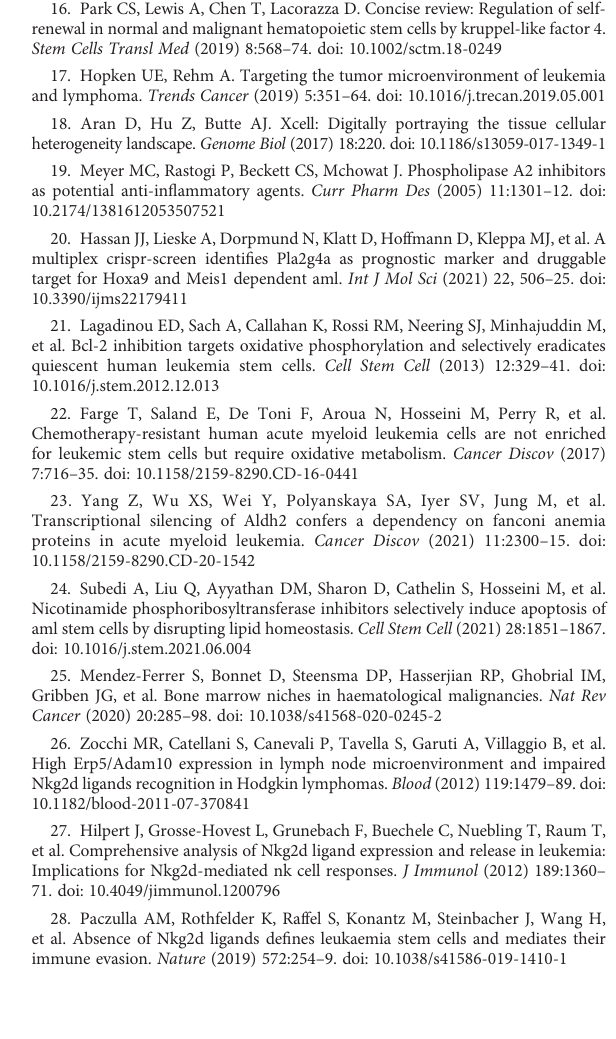
SUPPLEMENTARY FIGURE 2 TheFAMformulaidenti fi esalterationsintheimmunemicroenvironmentofAML patients in VC database. (A) GO analysis of the low risk (LR) and high risk (HR) cohortsintheVC. (B) KEGGnetworkanalysisoftheLRandHRcohortsintheVC. (C – F) GSEAanalysisofLRandHRcohortsintheVC. (G) Analyzetheimmunecell populationsoftheLRandHRpatientsintheVCusingtheXCELLalgorithm. SUPPLEMENTARY FIGURE 3 Kaplan-Meier analysis of AML patients based on the expression level of individualFAM-relatedgenes.Kaplan-MeieranalysisofAMLpatientsinthe VC based on the expression levels of SCD, SLC22A5, ACADS, MLYCD, ACSL3, and CBR1. Signi fi cance: *P<0.05, **P<0.01,